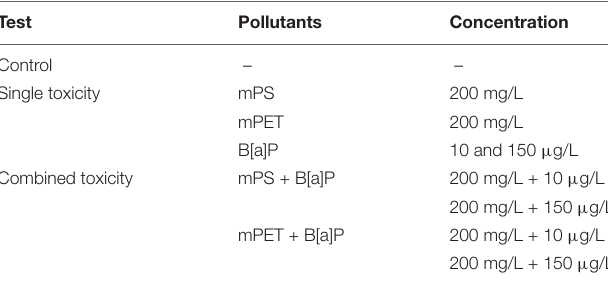
TABLE 1 | Experimental design in this